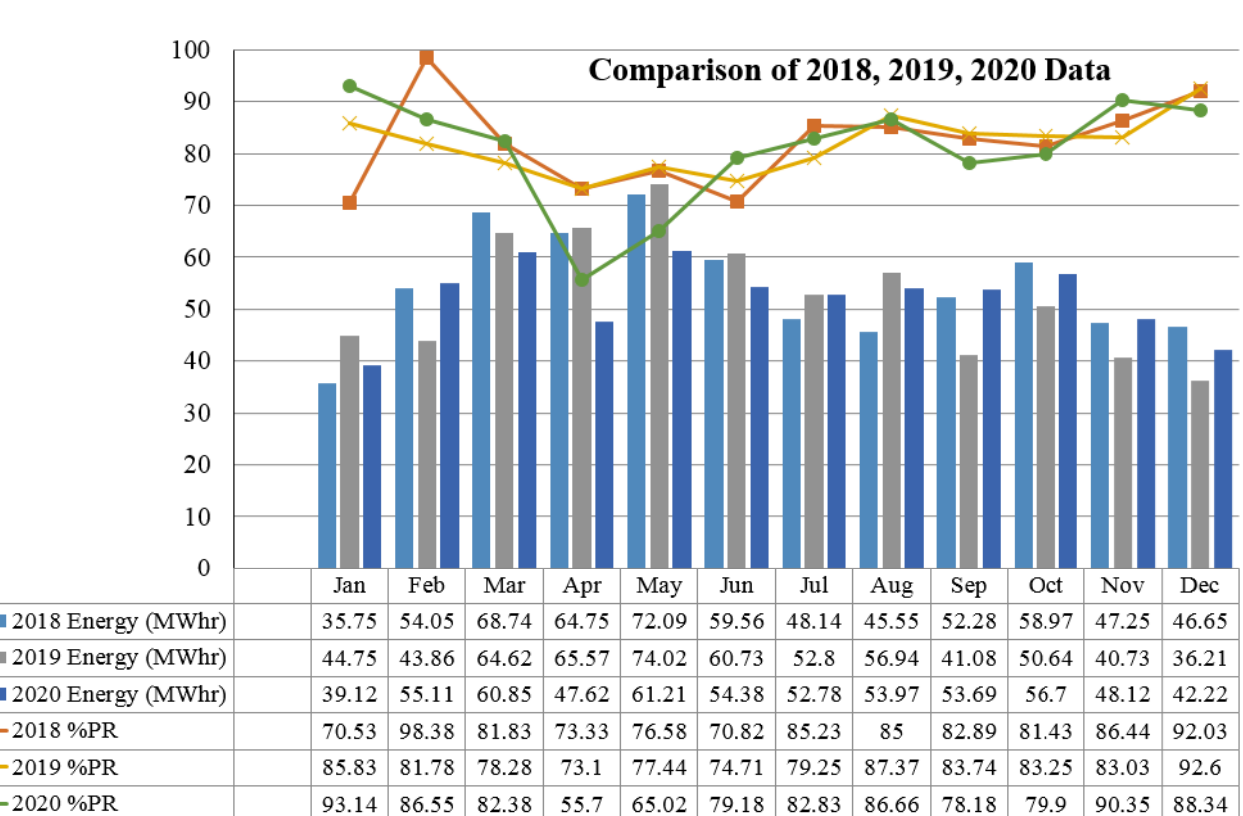
Figure 8. Comparison of Generated Energy in 2018, 2019, and 2020 of 467.2 kWp Plant (P 1 + P 2 + P 3 ). The Performance Ratio of the last three years (i.e., 82.04 in 2018, 81.69 in 2019, and 80.68 in 2020) is shown in Figure 9. It can also be seen that the degradation of solar panels is about 0.35% to 1.01% yearly, i.e., a positive sign that the installed SPV system can be in working condition for the next 20